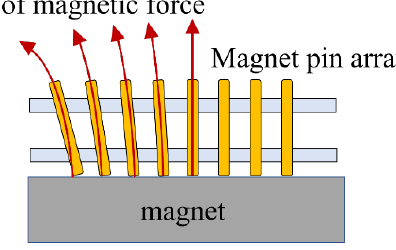
Figure 7. Magnetic lines of force in the setup. The magnetic field lines of the base magnet have a tangential component, generating frictional force between the pin magnet and the pin insertion acrylic plate.